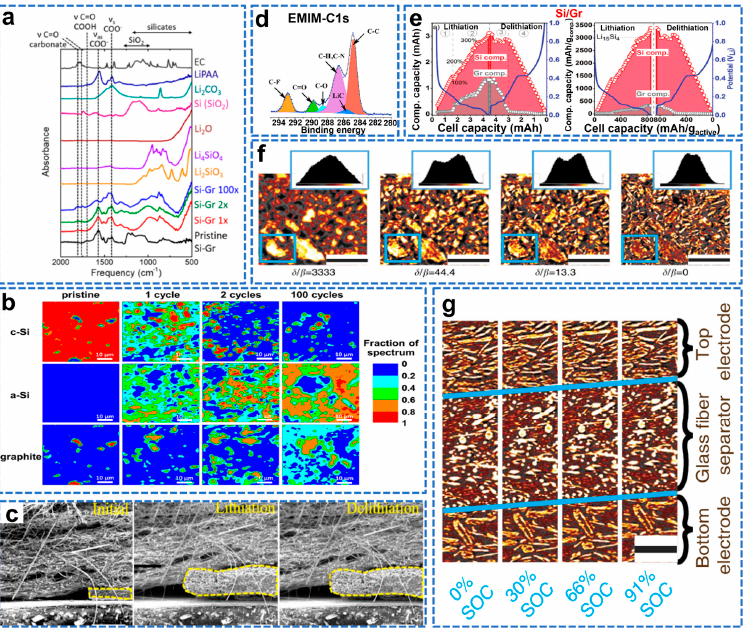
Figure 13. ( a ) FTIR spectra of the pristine Si–Gr anode and the Si–Gr anodes after 1 cycle, after 2 cycles, and after 100 cycles, ( b ) RAMAN maps of Si–Gr anodes taken before cycling (pristine), after 1 formation cycle, after 2 formation cycles, and after the full cycling protocol (100 cycles) [129]. ( c ) Morphological evolution of Si/C electrodes at 60 ◦ C and in situ SEM images for EMI, ( d ) C1s high − solution XPS spectra of surface components formed on Si/C electrodes after 20 cycles with corresponding ionic liquids in coin cell at 60 ◦ C [130]. ( e ) Capacity and specific capacity of the Gr and Si components in a Si–Gr electrode during lithiation and de − lithiation [131]. ( f ) Comparison of a slice in the bottom electrode, where the phase has been retrieved with different ratios. Insets show the respective color − scale histograms, ( g ) Vertical cuts through the sample at different states of charge